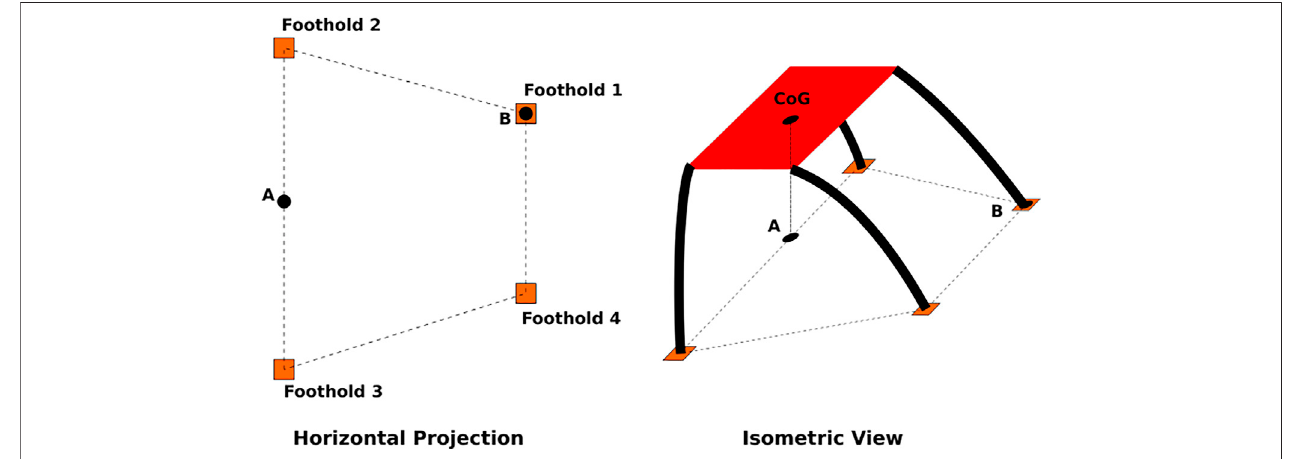
FIGURE2 | Diagram showingthe horizontalfoothold projection (left) and an simpli fi ed isometric viewofthe robot (right). Static analysis shows theforce required of thelegatfoothold1hasalowerboundof N =0occurswhentheCoMisoverpointA,asshownintheisometricview.Theupperbound N = F robot /2occurswhentheCoM is over point